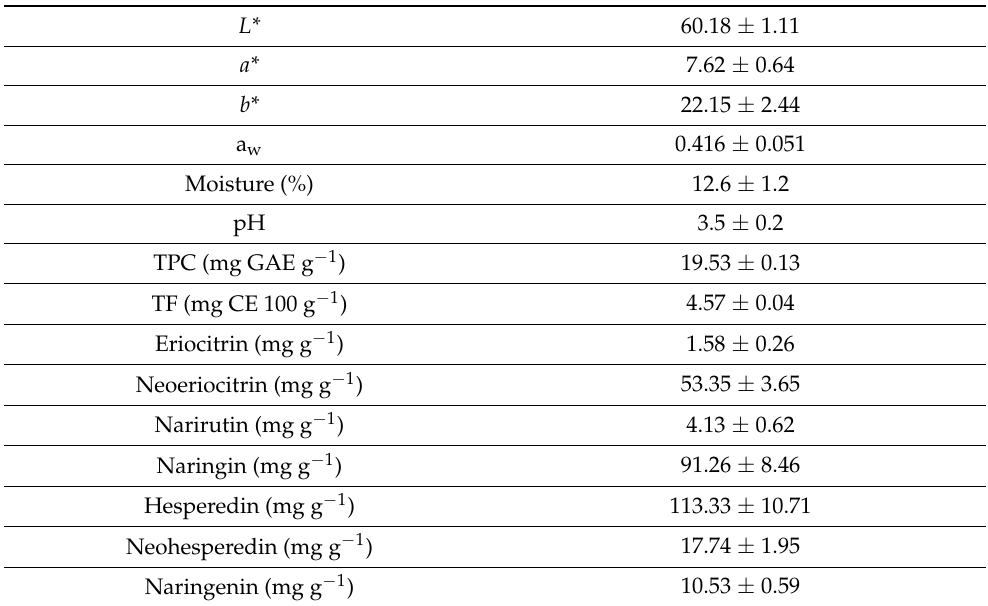
Table 2. Physical-chemical, antioxidant properties and concentration values of Individual Flavonoids (IF) in Bergamot Pastazzo Flour